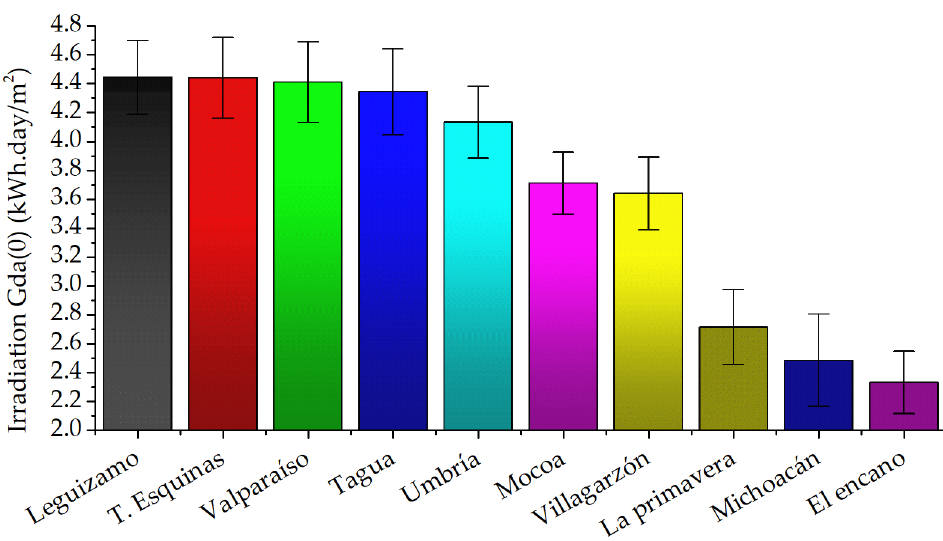
Figure 5. Location of IDEAM’s weather stations with solar brightness data in the department of Putumayo.